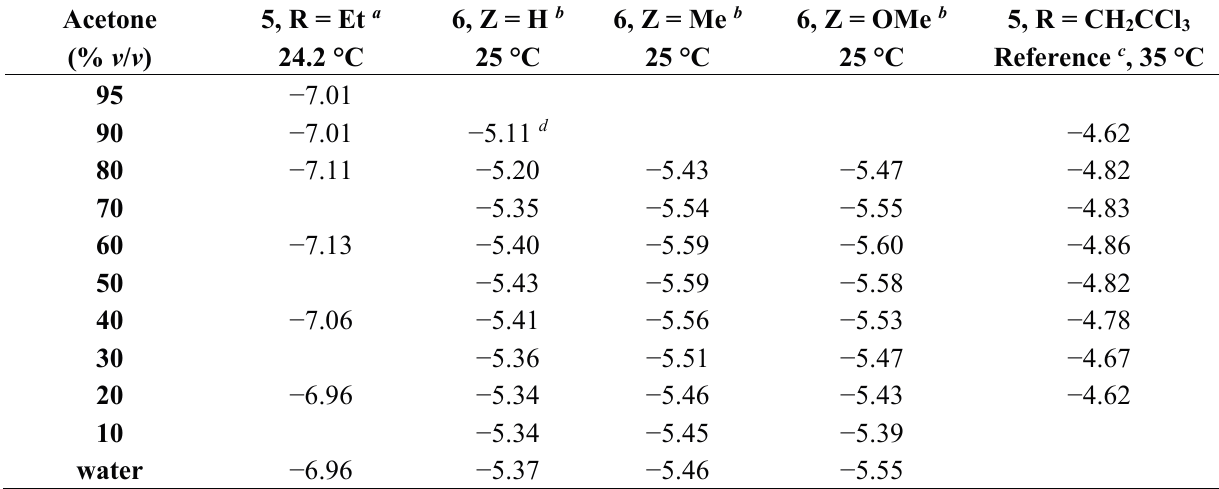
Table 1. Approximately constant values of logarithms of calculated third order rate constants (Equation (3)) for solvolyses of chloroformates in acetone-water.